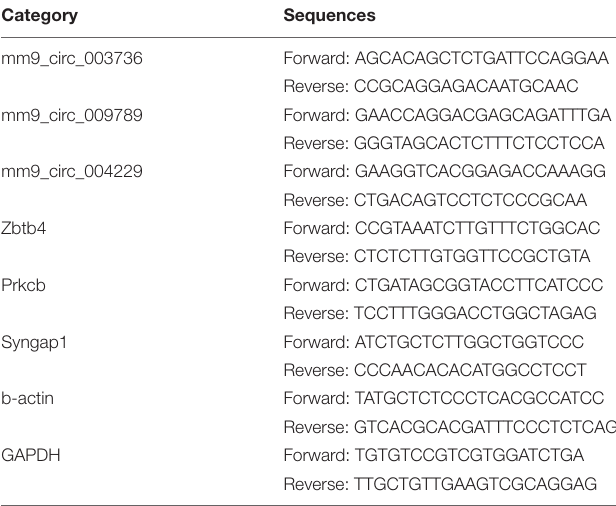
TABLE 1 | Primers Sequence for real-time